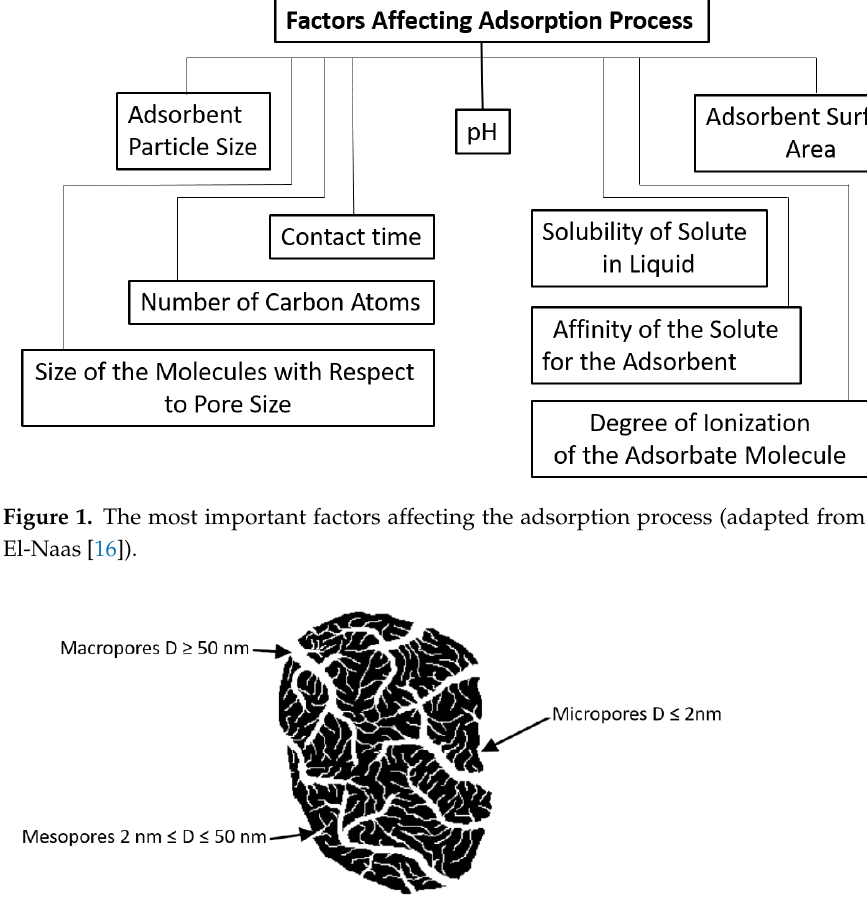
Figure 1. The most important factors affecting the adsorption process (adapted from: Muftah H. El-Naas [16]).